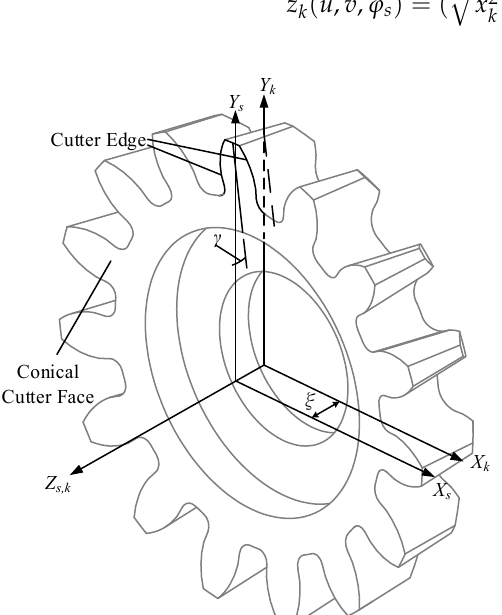
Figure 5. Cutter edge and conical cutter face of a spur shaping cutter.